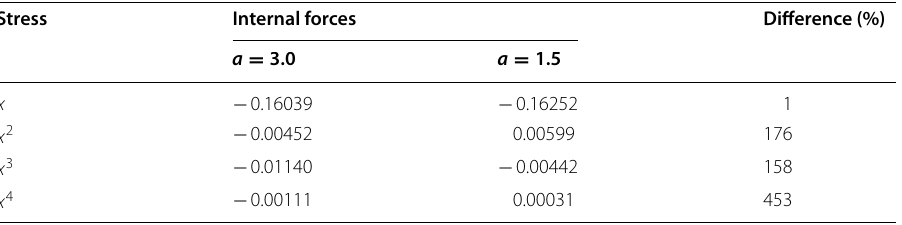
0.16252 1 − 0.00442 158 −